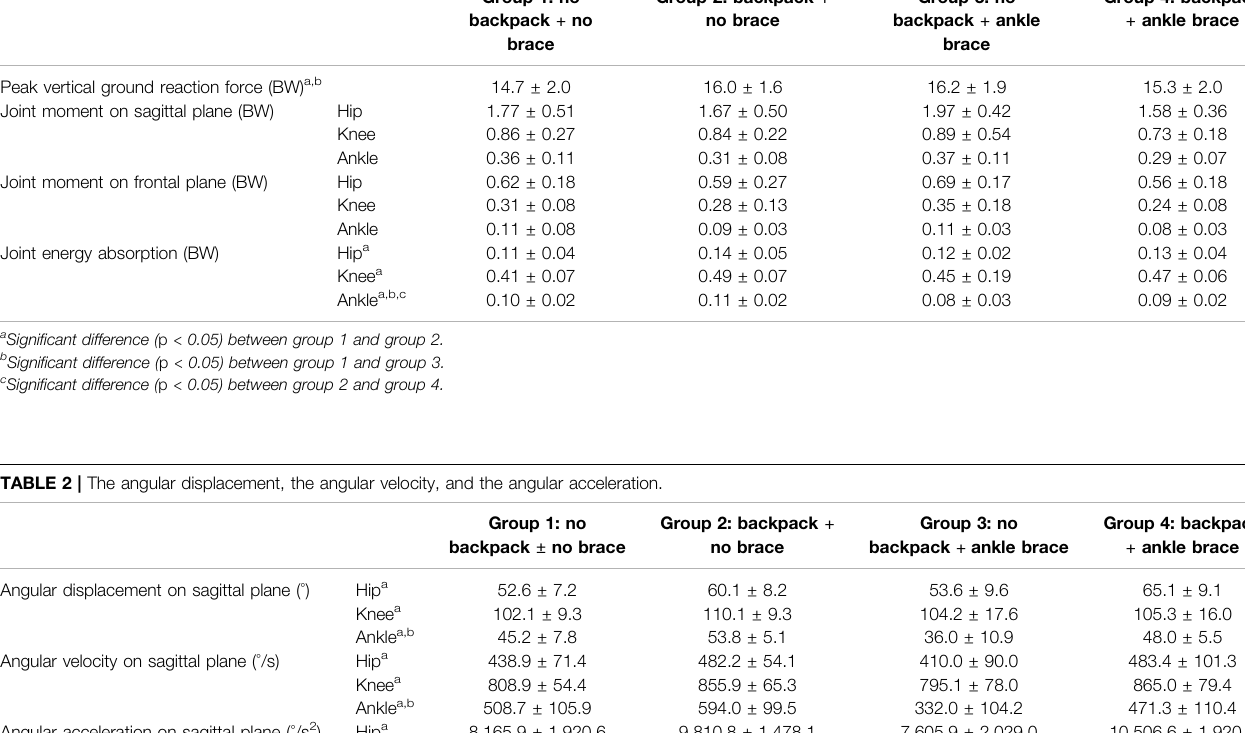
Group 3: no Group 4: backpack backpack + ankle + ankle brace brace